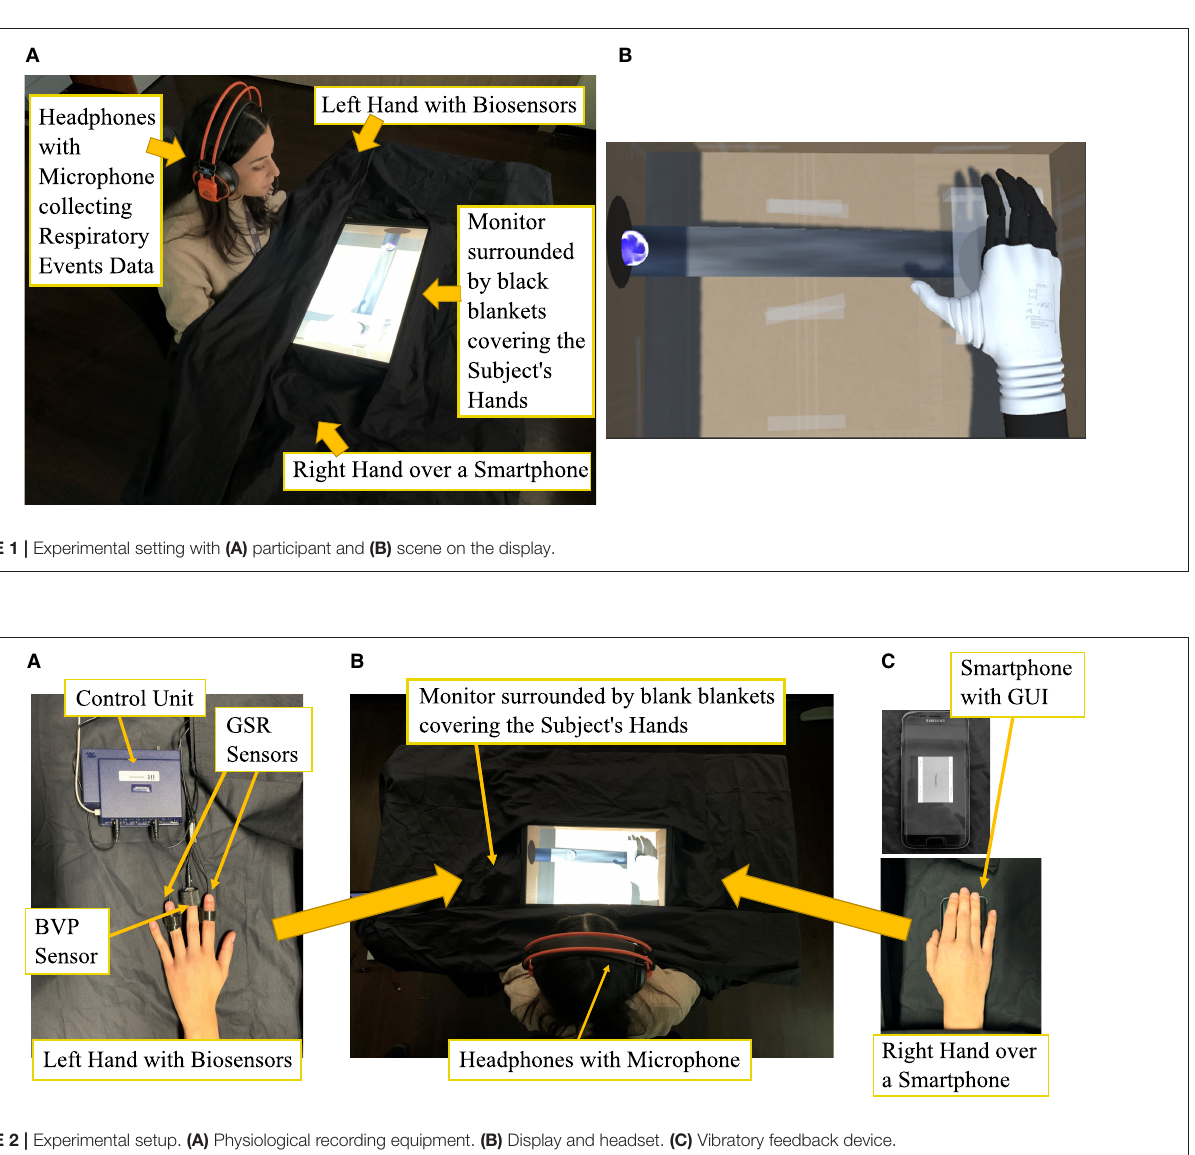
of the index finger and the ring finger as in Gümüslü et